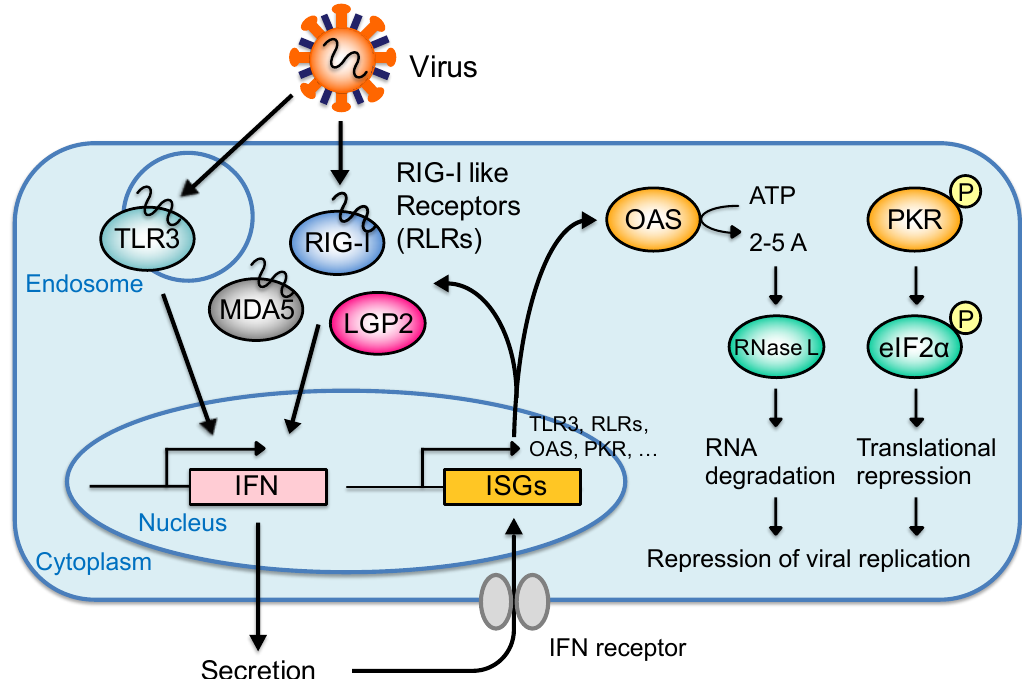
Figure 2. The interferon (IFN) response directed by exogenous RNAs. Exogenous RNAs such as viral RNAs are detected by toll-like receptor 3 (TLR3) in the endosome or retinoic acid-inducible gene I (RIG-I)-like receptors (RLRs) in the cytoplasm. Activated TLR3 or RLRs transfer signals to downstream molecules, inducing IFN production. Among RLRs, laboratory of genetics and physiology 2 (LGP2) does not contain caspase recruitment domain (CARD), which is necessary for signal transfer. The secreted IFN is recognized by the IFN receptor on the cell surface in a paracrine or autocrine manner, inducing the expression of IFN-stimulated genes (ISGs). An ISG, either 2 (cid:48) -5 (cid:48) -oligoadenylate synthetase (OAS) or protein kinase R (PKR), activates RNase L via 2-5A or phosphorylates eIF2 α to carry out RNA degradation or translational repression, respectively. Activation of the IFN response represses viral replication and e ff ectively excludes viruses while limiting damage to the